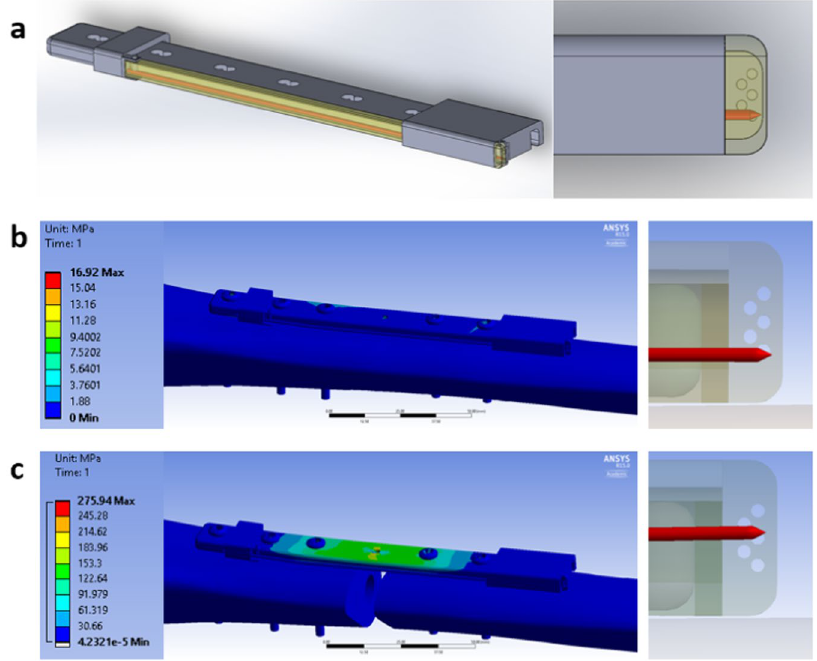
Figure 1. Passive strain sensor design. ( a ) Solidworks model of passive strain sensor components mounted to an orthopedic plate modelled after Synthes 4.5 mm proximal tibia plate. ( b ) FEA of intact tibia geometry with attached plate sensor. Note no change in sensor response when comparing no load to 400 N compressive load. ( c ) FEA of tibia with 1 cm osteotomy treated with internal fixation. The plate is supporting all of the axial